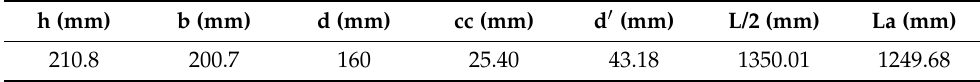
Table 6. The geometrical parameters for Almusallam (1997)